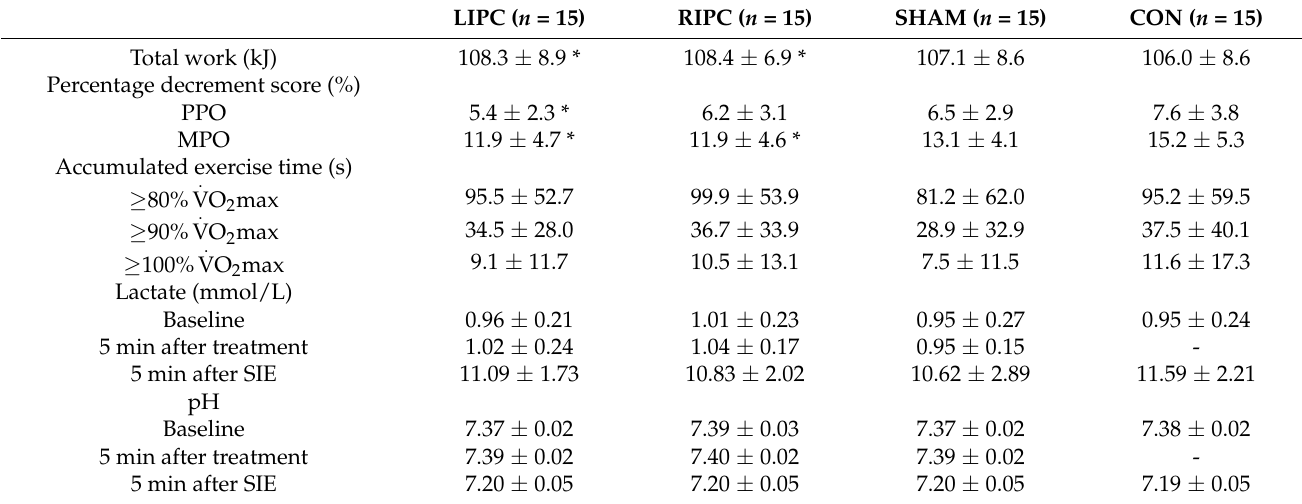
Table 1. Effects of local and remote ischemic preconditioning on exercise performance and physiological responses during sprint interval exercise